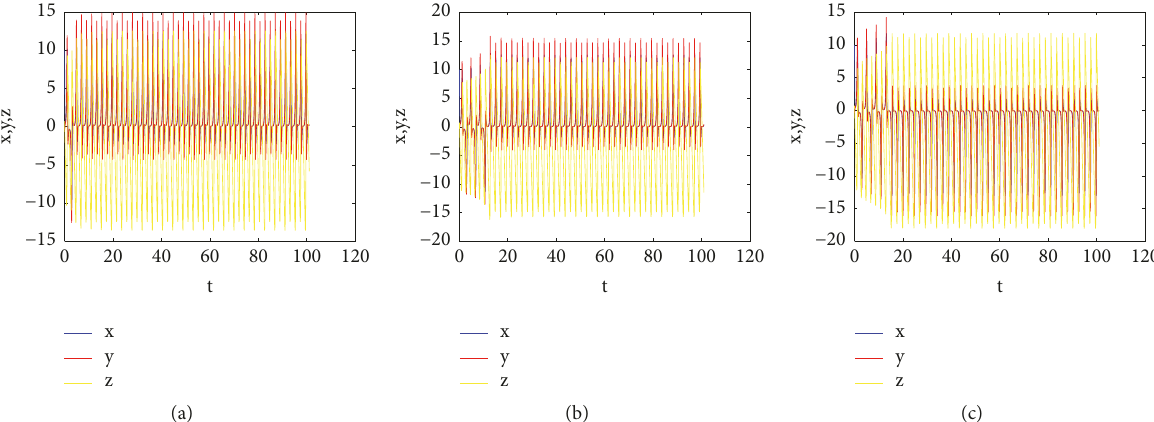
Figure 11: The time series plots of 3D autonomous chaotic Lorenz-type system for Experiment 3: (a) 𝑐 = 1 ; (b) 𝑐 = 2 ; (c) 𝑐 = 3